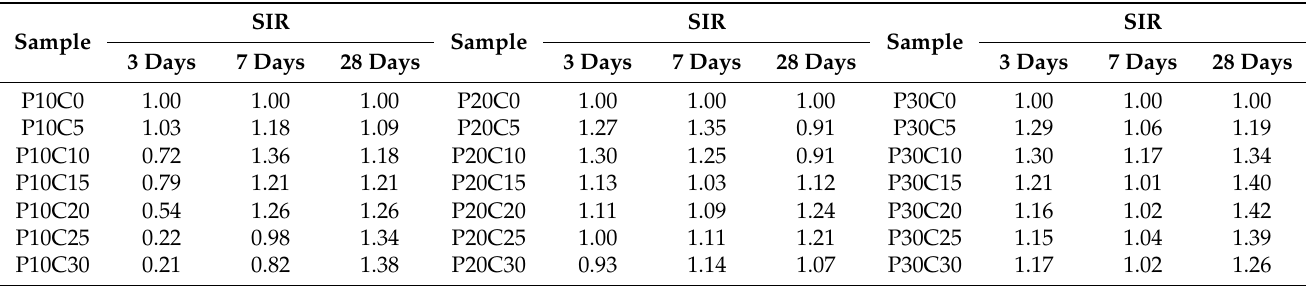
Table 4. The strength increase ratio of CPDS prepared by different cement and CCR